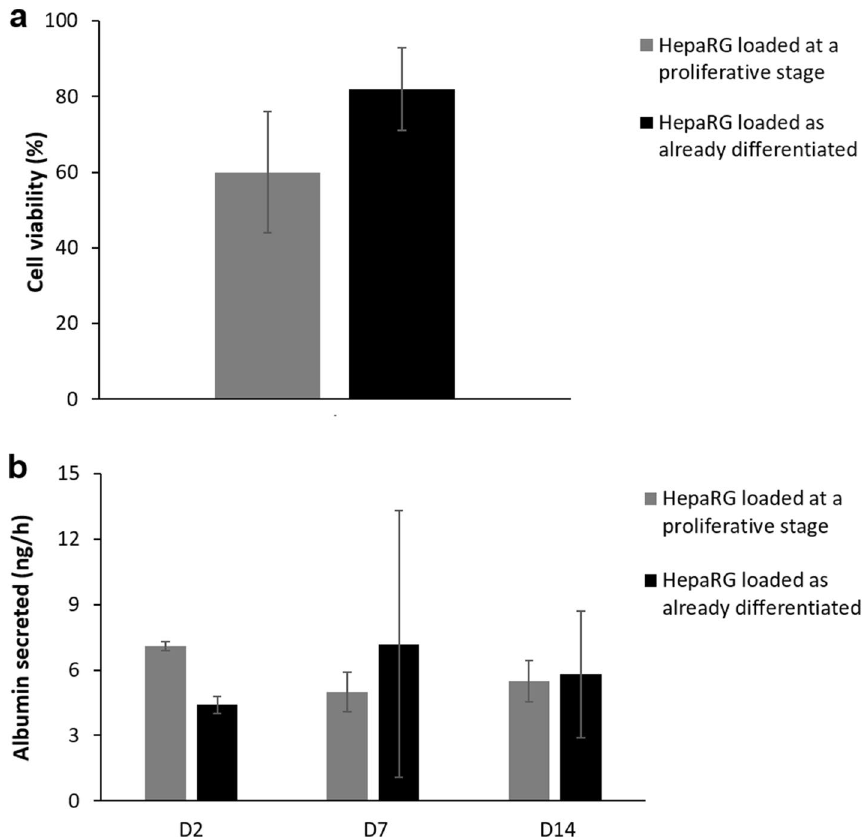
Figure 4. Cell viability and secretion of albumin on chip depending on the differentiation stage at which they were loaded (grey for proliferative HepaRG cells and black for already differentiated cells). ( a ) Cell viability after 15 days of culture on chip (n = 3 chips per condition). ( b ) Secretion of albumin per chip after 2, 7, or 14 days of culture (n = 2 at day 2; n ≥ 3 at day 7 and